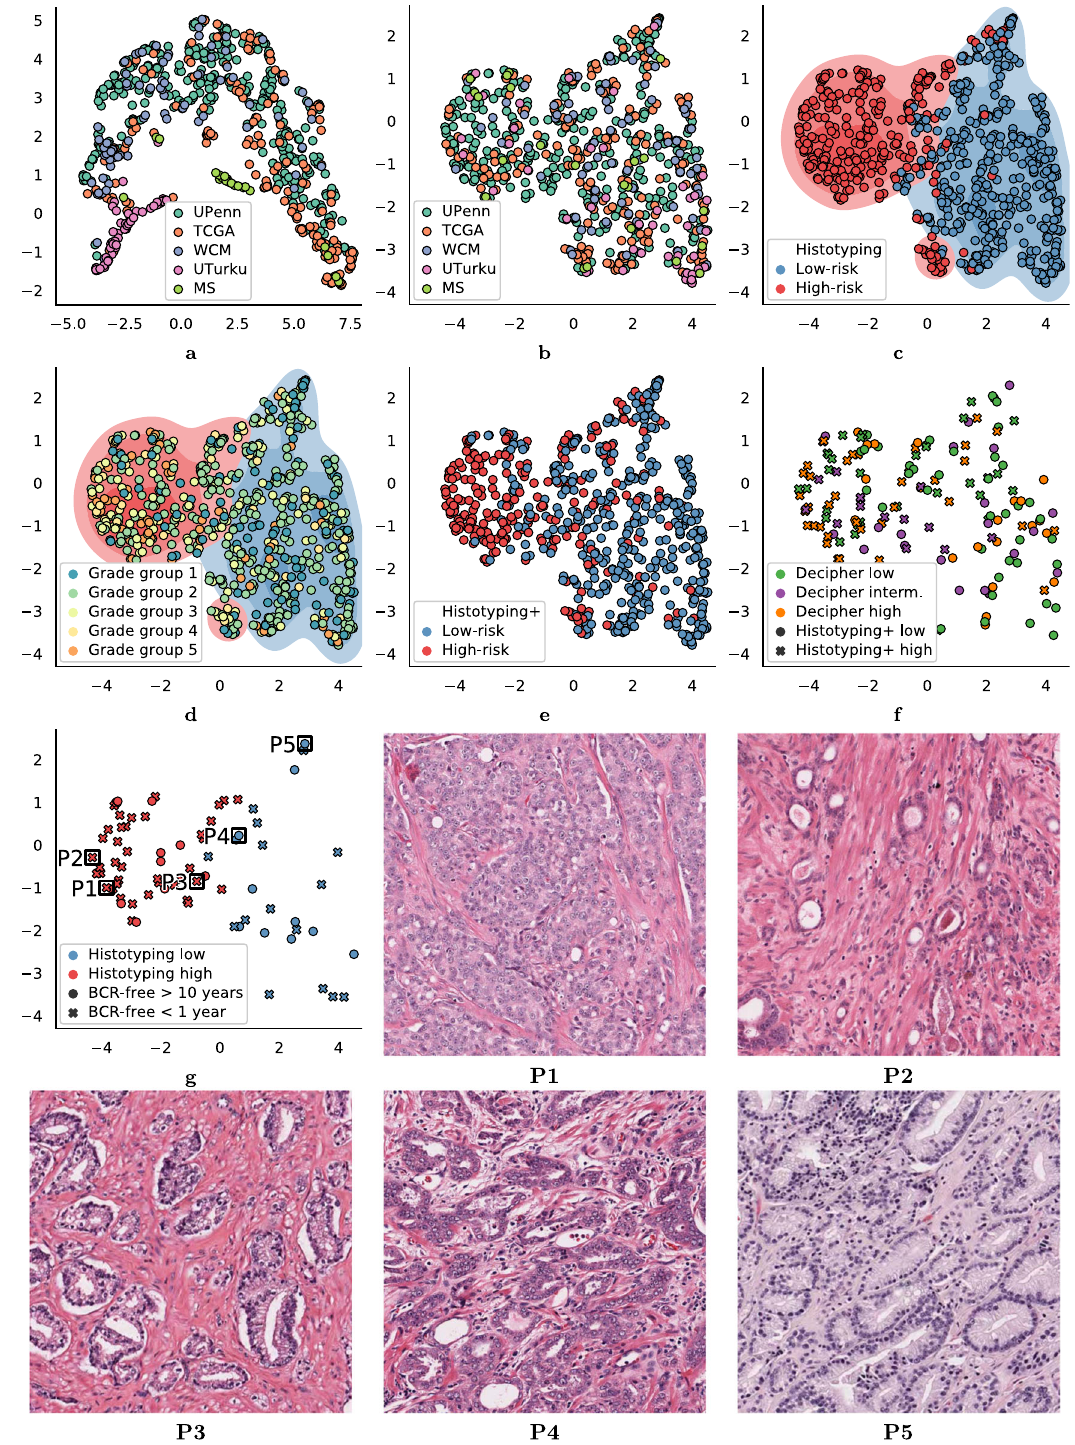
Fig. 1 UMAP embedding of image properties and Histotyping features. Shown are UMAP projections based on ( a ) image properties and ( b – g ) the six features used in Histotyping on the entire validation set. Each dot represents a patient, and dots are colored according to: a , b the site the patient originated from, c Histotyping risk group, with kernel density, estimates shown for the Histotyping risk groups, d Gleason grade group, including kernel density estimates from ( c ), ( e ) Histotyping + risk group, and ( f ) Decipher score, with markers indicating Histotyping + risk group. g shows the patients who had BCR in less than one year or were BCR-free for more than 10 years, with outcomes indicated by marker shape. Regions of interest from select patients are shown from various locations in ( g ). Patients P1, P2, and P3 were Histotyping high-risk patients who had early BCR, while P4 and P5 were low-risk patients who were BCR free for more than 10 years.